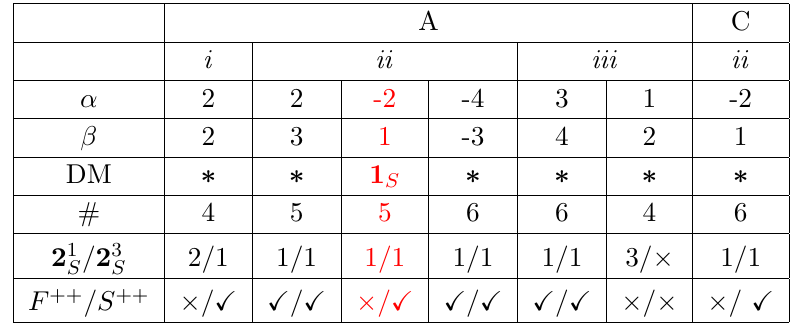
Table 21. The same as in table 19 for diagram 3.c. The SU ( 2 ) L , Z 2 and U ( 1 ) Y assignments for this model are given in table 18.